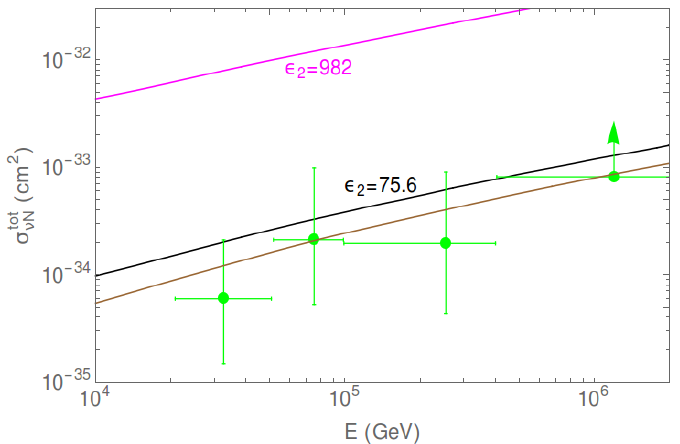
Figure 4 . Constraints on NSI described by eq. (4.4) in presence of a Z 0 of mass 5 GeV. Colour coding is the same as in (cid:12)gure